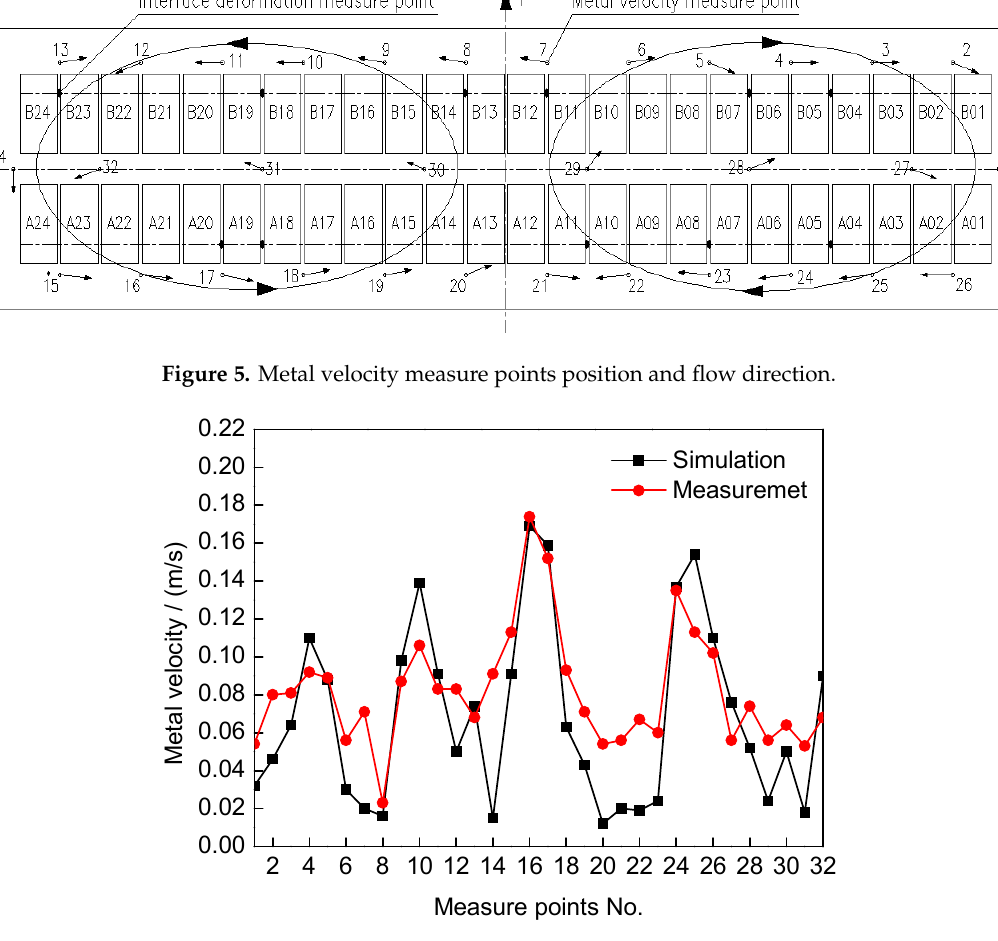
Figure 6. Metal velocity comparison between simulation and measurement (m/s).